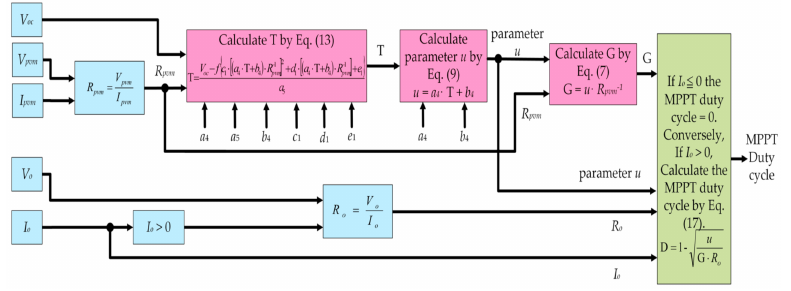
Figure 6. Proposed PVM-QR MPPT algorithm block.